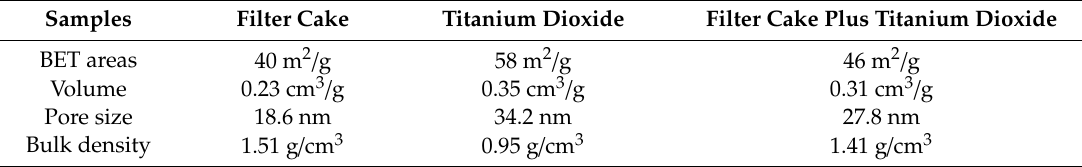
Table 1. Summary of the BET data for the powdery catalysts produced by di ff erent titanium sources.